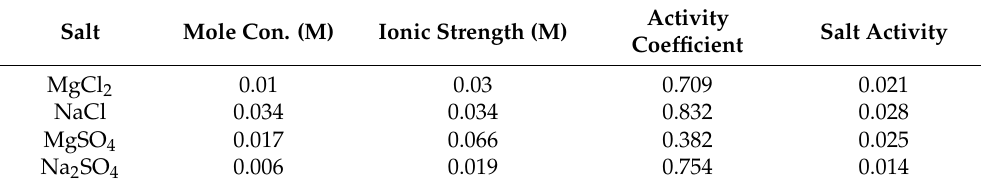
Table 3. The molar concentration, ionic strength, activity coefficient, and salt activity of various salt solutions, including MgCl 2 , MgSO 4 , NaCl, and Na 2 SO 4